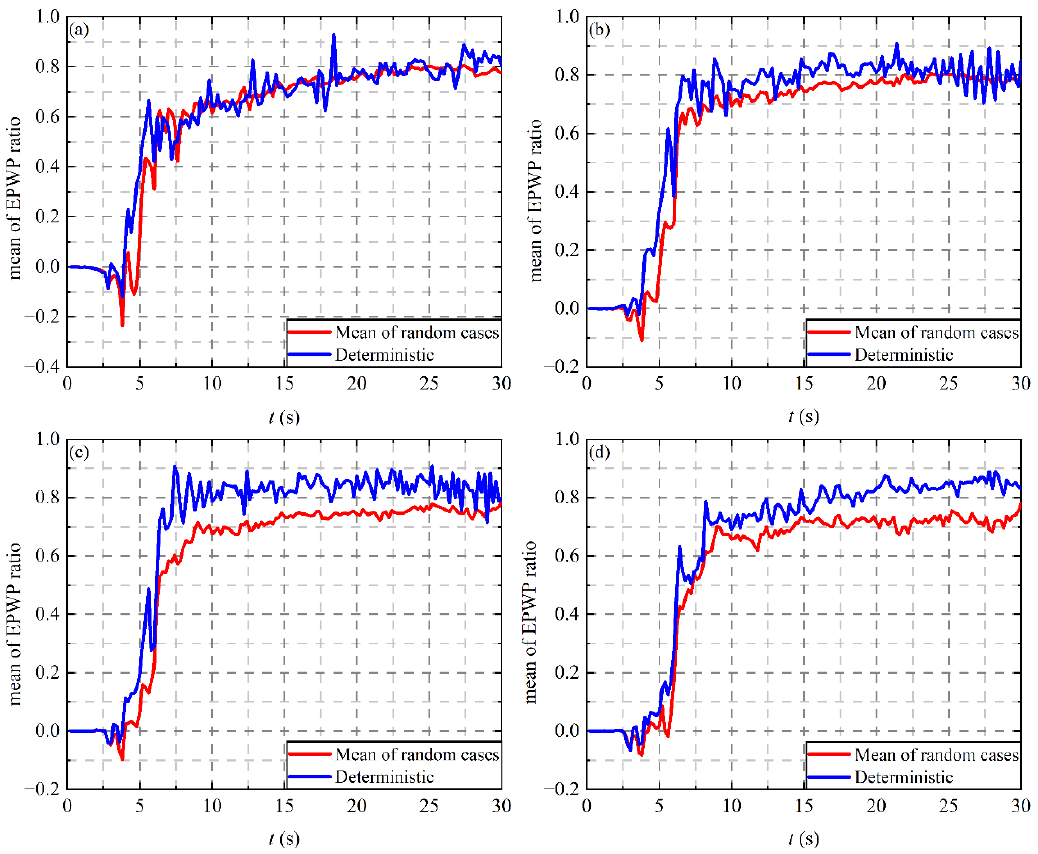
Figure 5. Comparison of the EPWP ratio under different embedment depths at Point A: ( a ) H = 6 m; ( b ) H = 8 m; ( c ) H = 10 m; ( d ) H = 12 m.